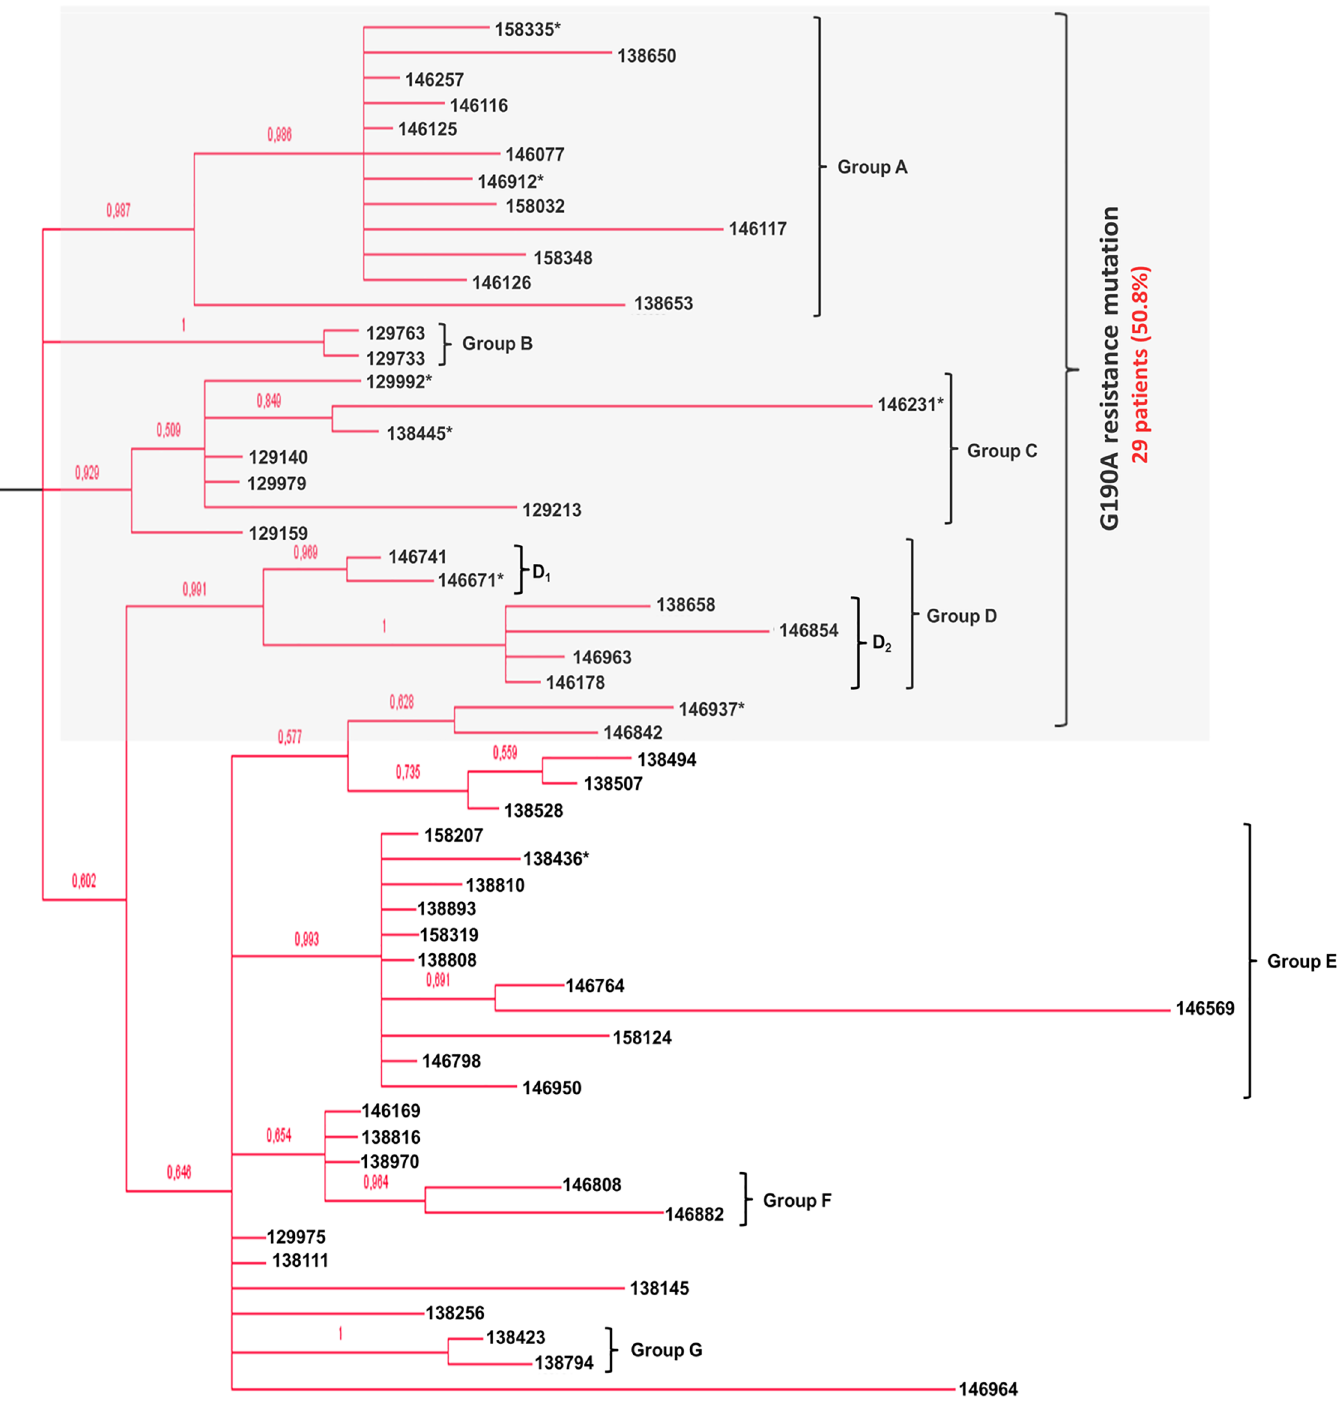
Fig 3. Subtree with the 55 CRF19 cpx sequences grouped together (pp = 0.895) conforming the identified outbreak as depicted in Bayesian inference of the phylogeny (see Fig 2). Sequencespresentingthe G190A mutation are highlightedwithin the light grey shadedsquare. Asterisks indicate the detection of V179I/A as